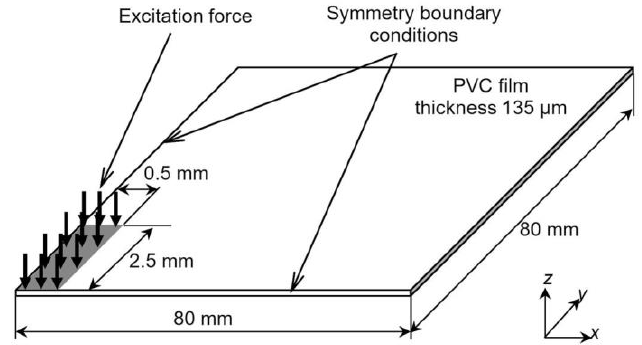
Figure 2. Graphical representation of the finite element model (dimensions are not to scale).